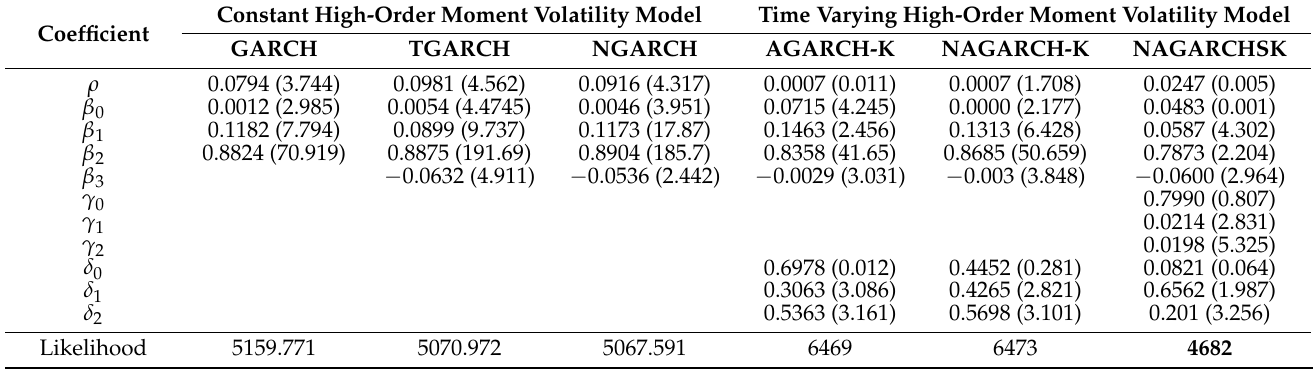
Table 1. Parameter estimation of the high-order moment volatility model for carbon return.